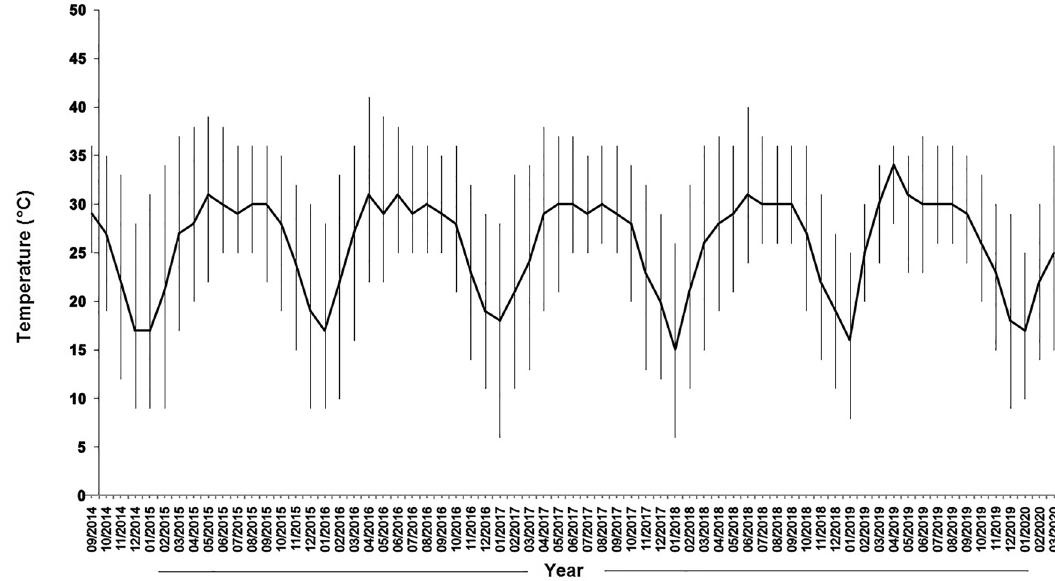
Figure 6. Temperature with the maximum and minimum recorded during surveying period atRajshahi, Bangladesh (Solid thick line indicates the average temperature in each month and thin line indicates maximum and